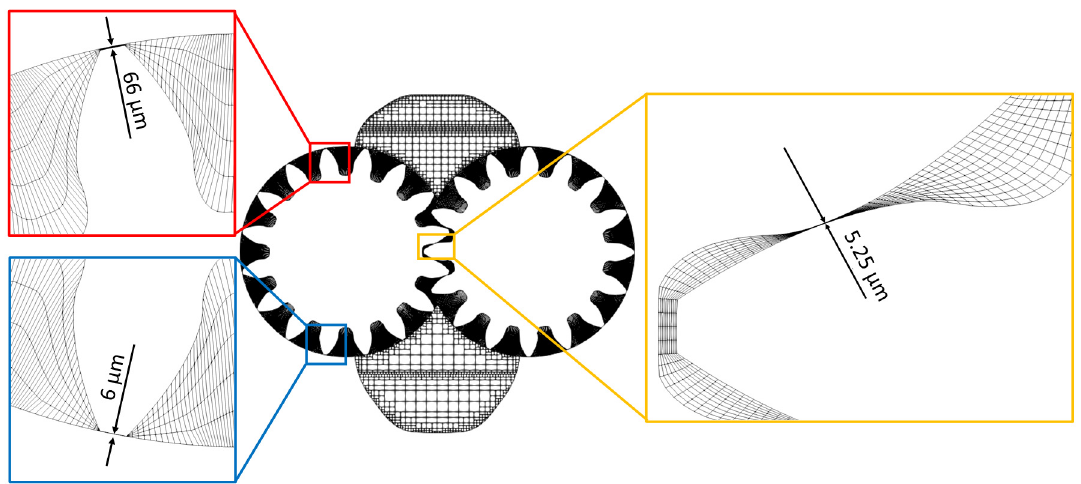
Figure 9. Section of the domain mesh—Teeth gap in the zoomed view.